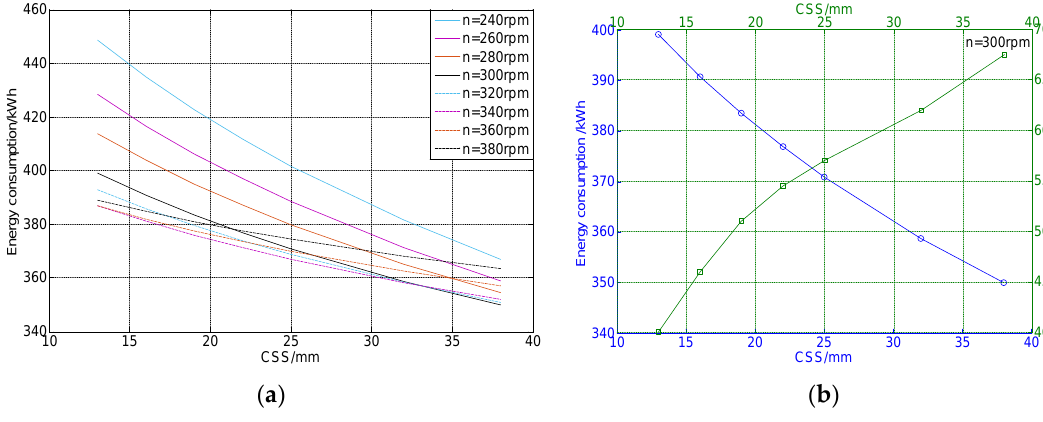
Figure 13. Relation of CSS and energy consumption: ( a ) CSS vs. energy consumption; ( b ) CSS, production and energy consumption.